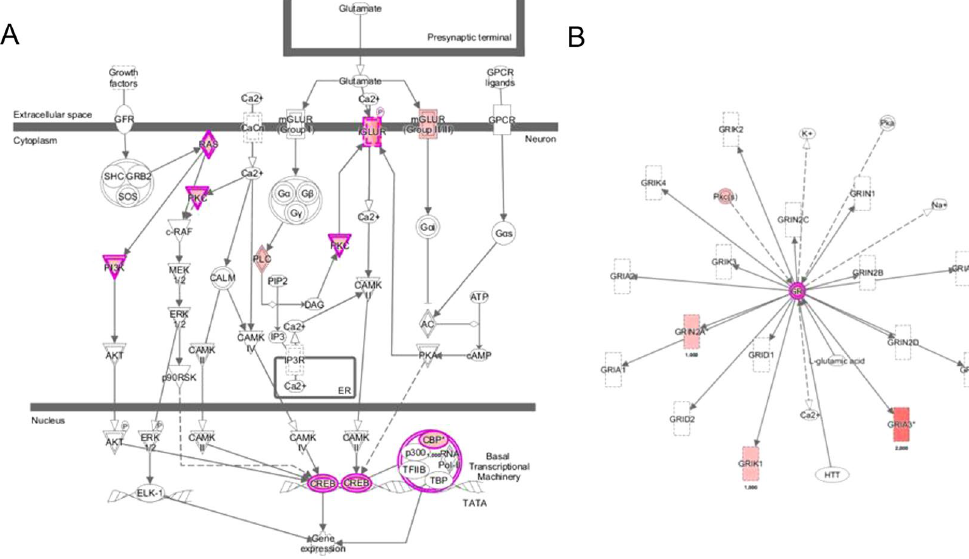
Figure 7. Canonical Pathway of ‘CREB Signaling in Neurons’ (IPA, p-value 3.02E-05). Color red: the darker, the more damaging mutations were found by exon sequencing. Color pink: overlap of genes within dataset of 282 damaging mutations. Color pink double bordered: shows more than one gene within a complex. Genes from the dataset involved in the pathway are: PRKDC, NRAS, TYK2, CREBBP, PIK3C2G, ATR, JAK2, PRKD3,